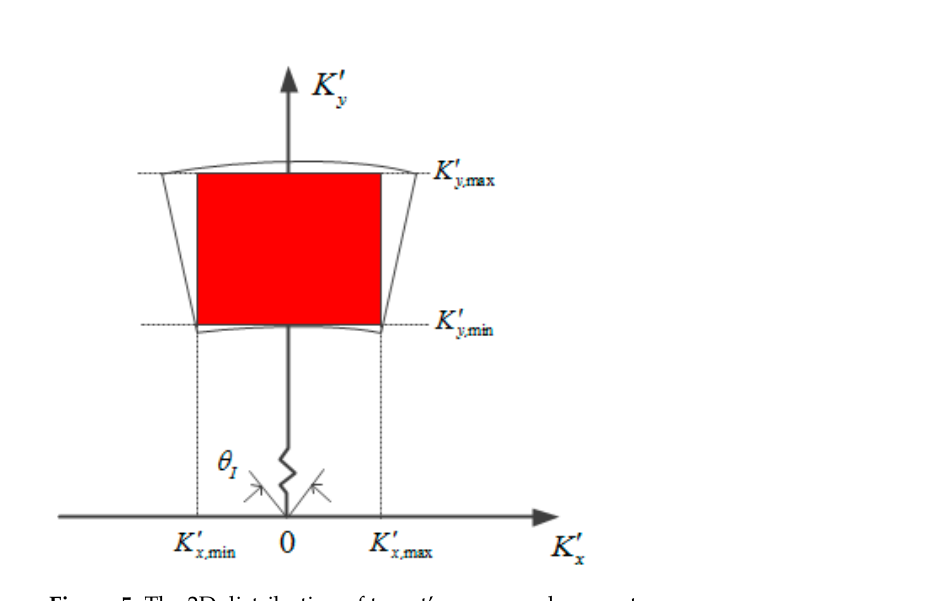
Figure 6. The relationship between azimuth integration angle and resolution.